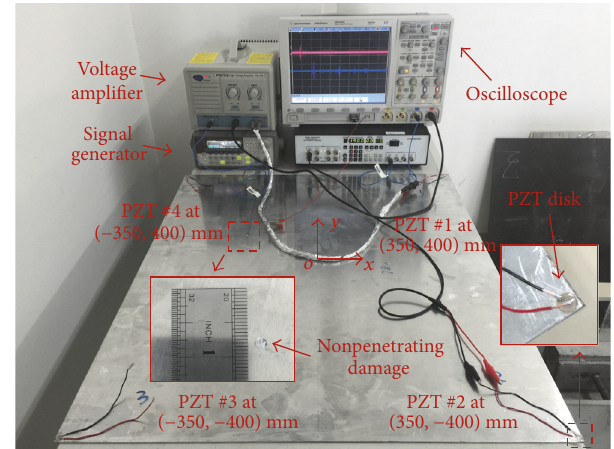
Figure 12: Experiment